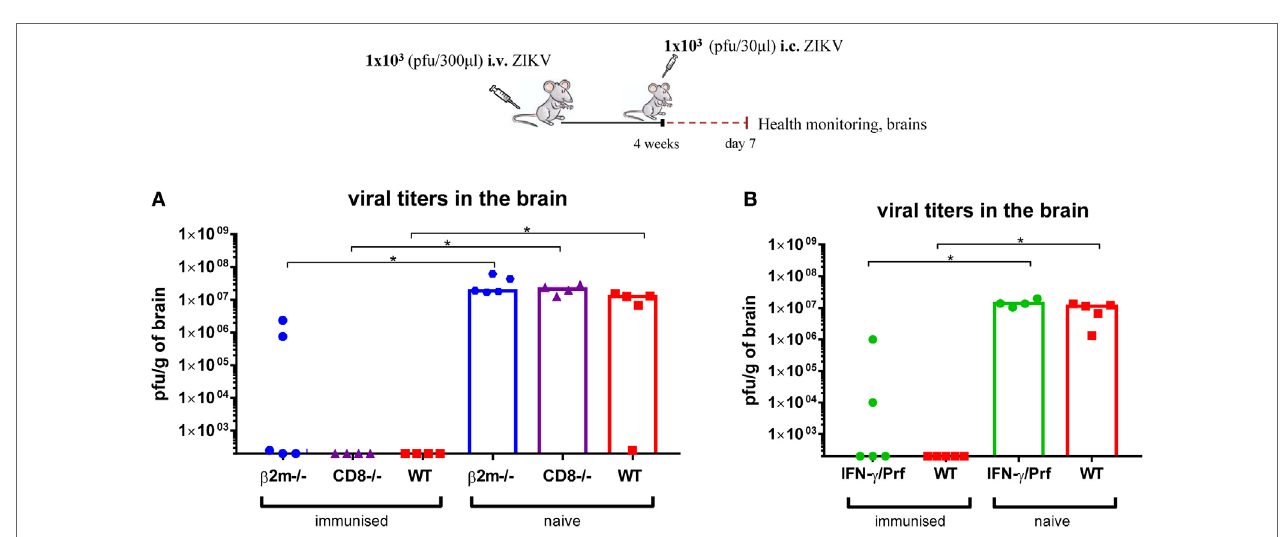
FigUre 12 | CD8 T cells are not essential for protection against Zika virus (ZIKV). β 2-microglobulin-deficient ( β 2m − / − ) and CD8 α -deficient (CD8 − / − ) (a) or IFN- γ / perforin double-deficient (IFN- γ /Prf − / − ) (B) mice were inoculated with 1 × 10 3 pfu ZIKV i.v. and 4 weeks later were challenged with 1 × 10 3 pfu ZIKV i.c. On day 7 post i.c. challenge, brains were removed and viral titers were measured by a plaque assay. For all deficient mice, a group of uninfected deficient mice was included for control. Additionally, wild-type (WT) C57BL/6 mice, inoculated with 1 × 10 3 pfu ZIKV i.v., and naive uninfected mice were used as positive and negative controls, respectively. The detection limit for virus in the brain was 250 pfu/g organ. Each dot represents an individual animal, and bars represent the medians of the groups. n = 4–5 mice/group, * p <